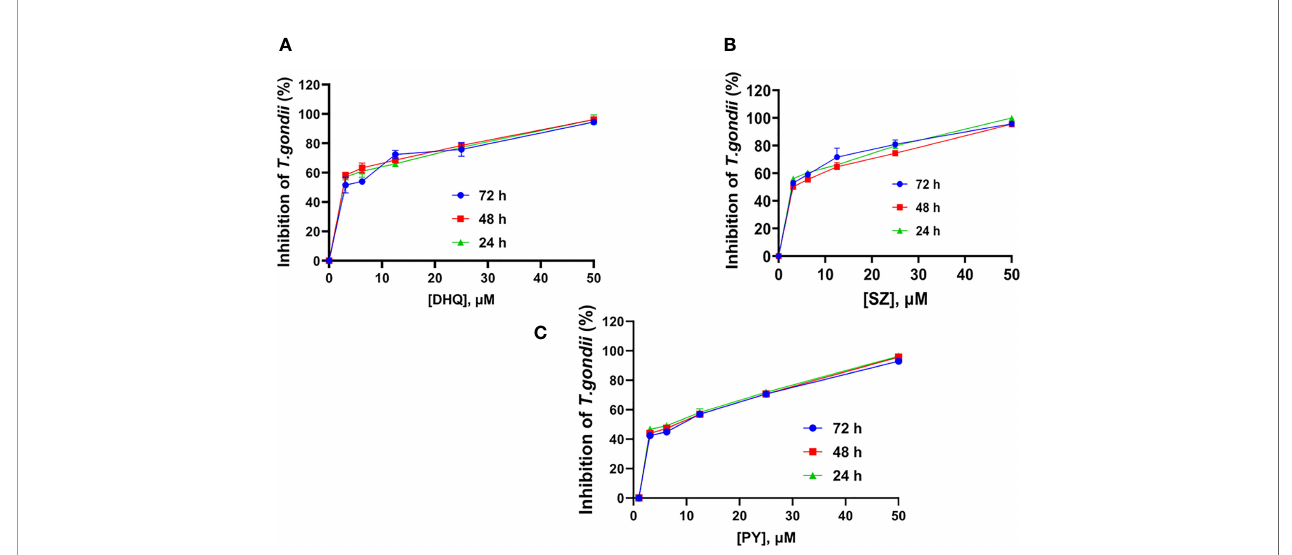
FIGURE 1 | Mean time-dose Kinetic inhibition curve of (A) DHQ, (B) SZ, and (C) PY against T. gondii tachyzoites growth in vitro at 24, 48 and 72 hours